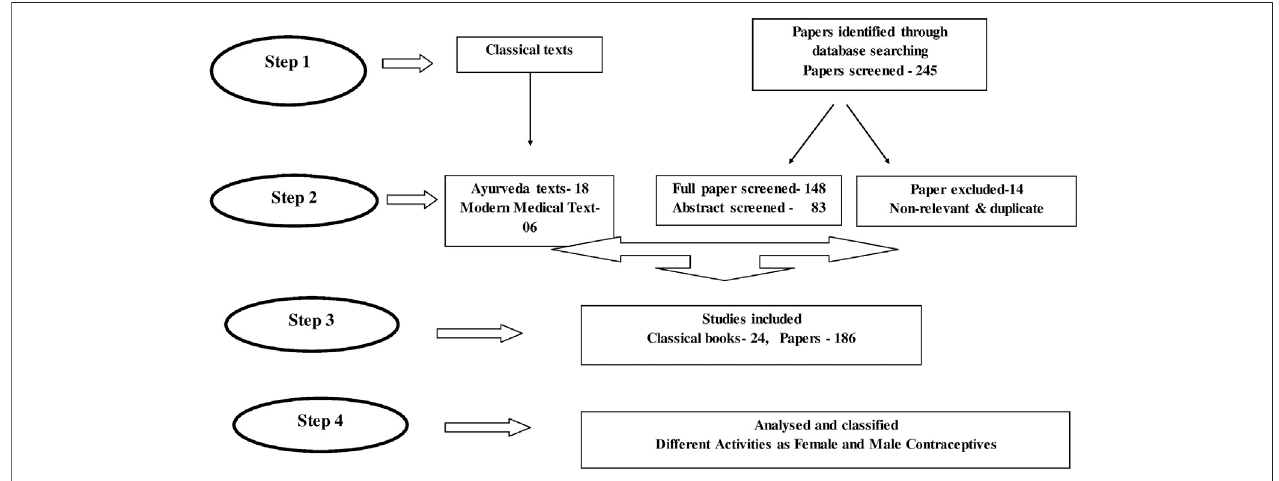
FIGURE 2 | Flowchart of the systemic review process searching for contraceptive